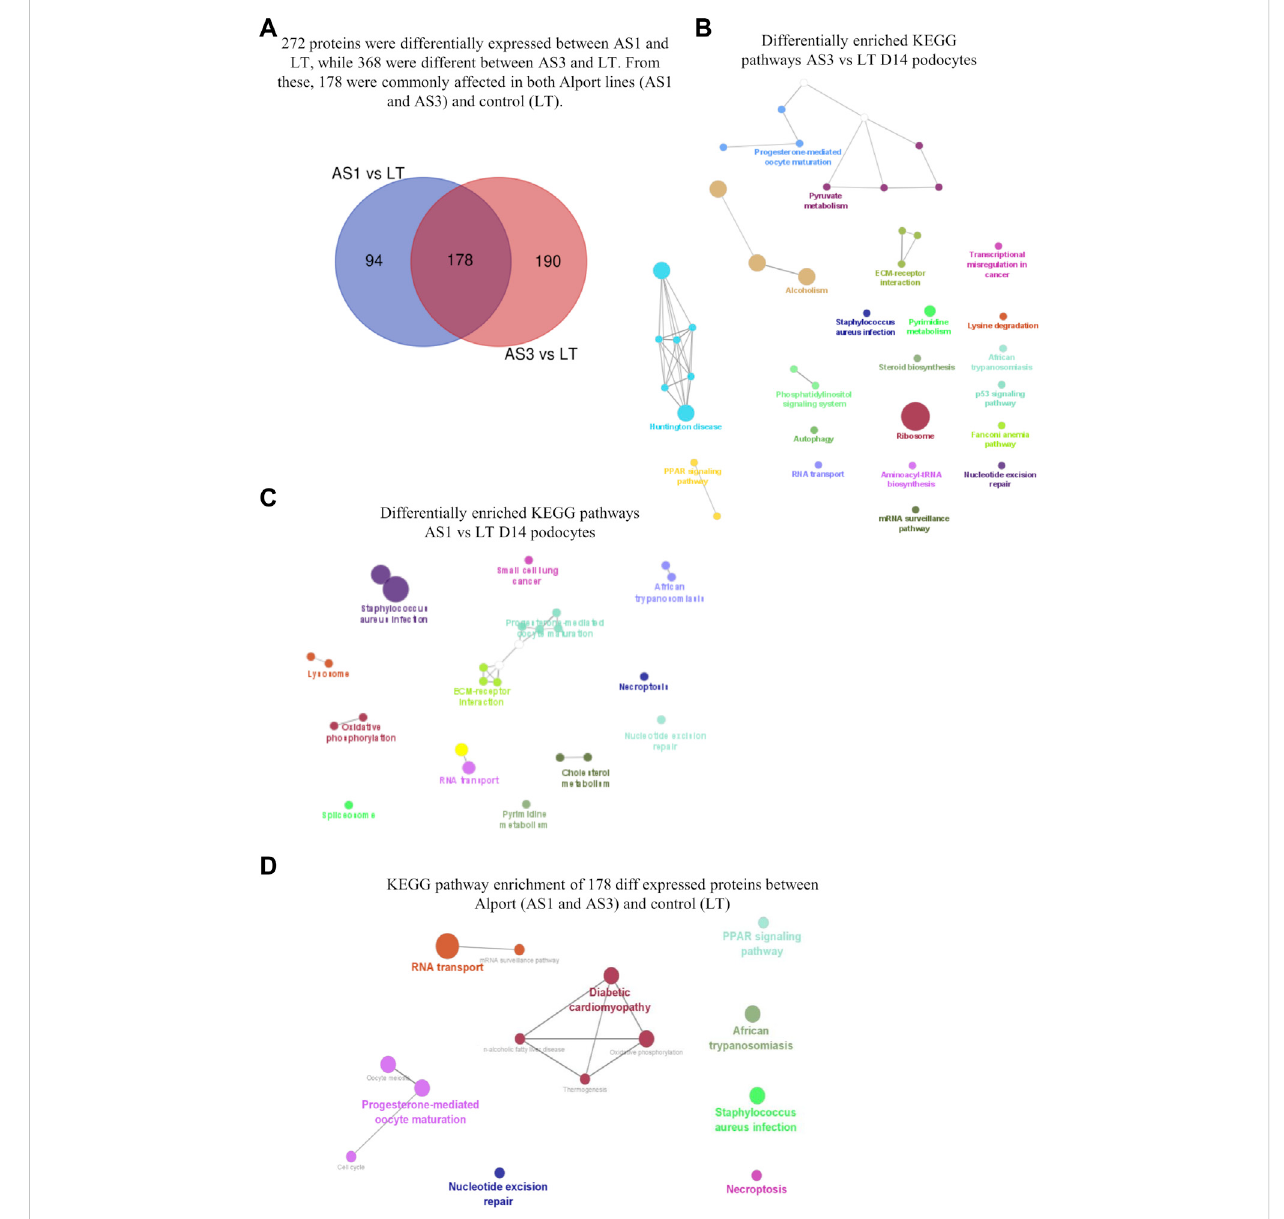
FIGURE 3 Proteomic analysis comparison of hiPSC-derived D14 podocytes from Alport disease (AS1 and AS3) and normal patients (LT) cell lines. In (A) , the Venn diagram highlighting thedifferentially expressed proteins from each comparison and those commonly affectedin both Alport celllines. The enriched KEGG pathways identi fi ed from the differentially expressed proteins between AS3 and LT (B) , AS1 and LT (C) and Both AS1 and AS3 vs. LT (D) . The analysis was performed using Cytoscape v 3.9.1 and its plug-in Cluego using the set of proteins differentially expressed ( p < 0.05) referred in each comparison.